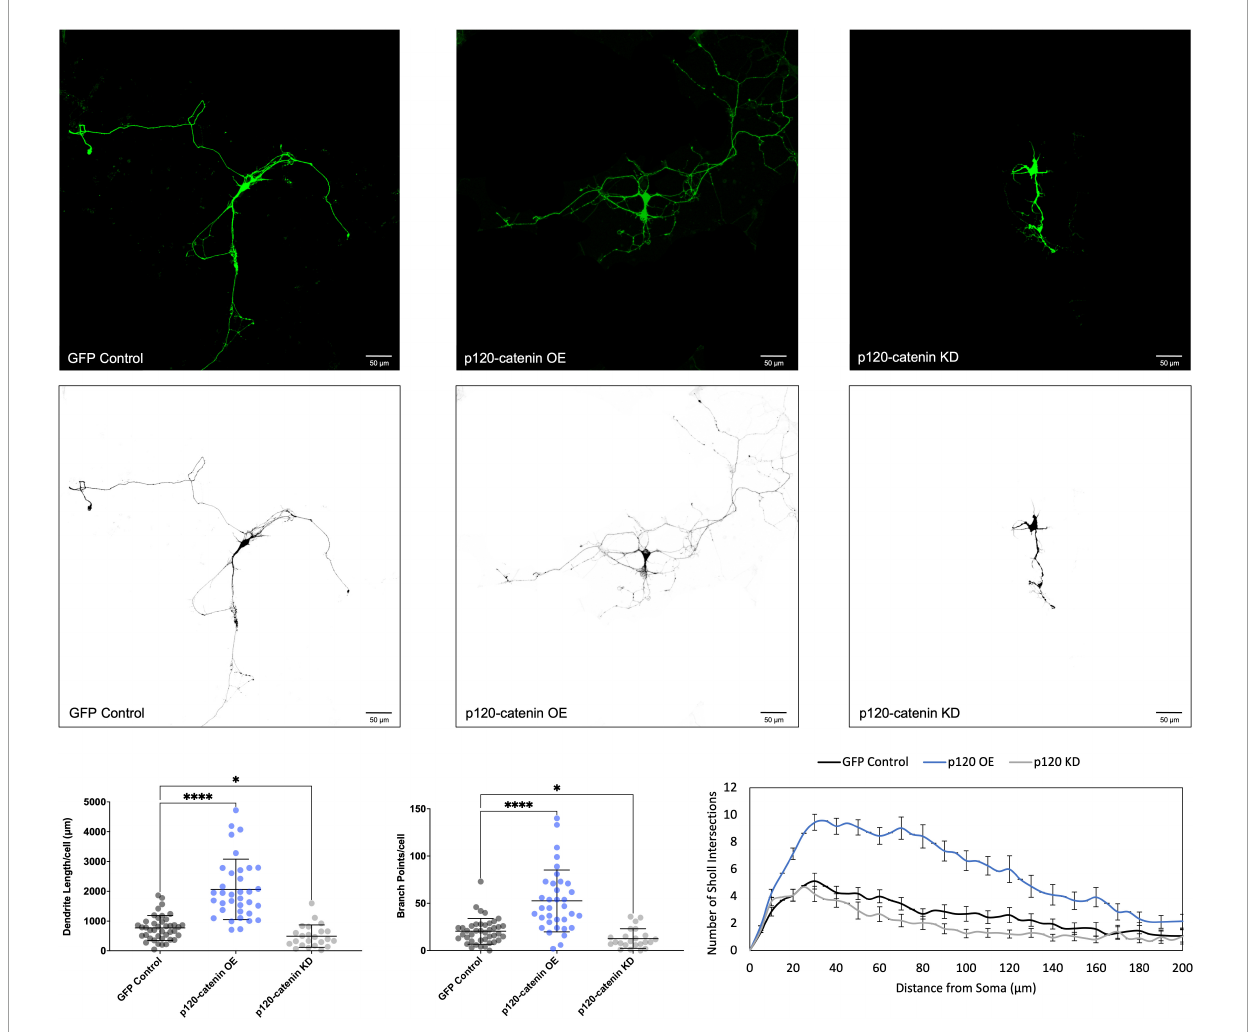
FIGURE3 Morphological effects of p120-catenin expression in developing rat primary hippocampal neurons. Example images are shown of neurons that have been transfected with GFP, exogenous p120-catenin, and shRNA to knockdown p120-catenin. Cells were transfected at 3 DIV and analyzed at 7 DIV. These images have been masked to eliminate other cells in the visual field for clarity. Quantification of the average dendrite length per cell and average number of branch points per cell per each condition are shown below on the left, and Sholl analysis for each condition to the right. The number of cells analyzed in each condition were 35 for p120-catenin OE, 23 for p120-catenin KD, and 41 for GFP control. Samples were taken from five biological replicates. Statistical significance was determined using a two-way Brown-Forsythe and Welch ANOVA tests with Dunnett’s T3 multiple comparisons post-hoc test. Significance was assigned at P < 0.05 for * and P < 0.0001 for ****. Chart values show mean and standard